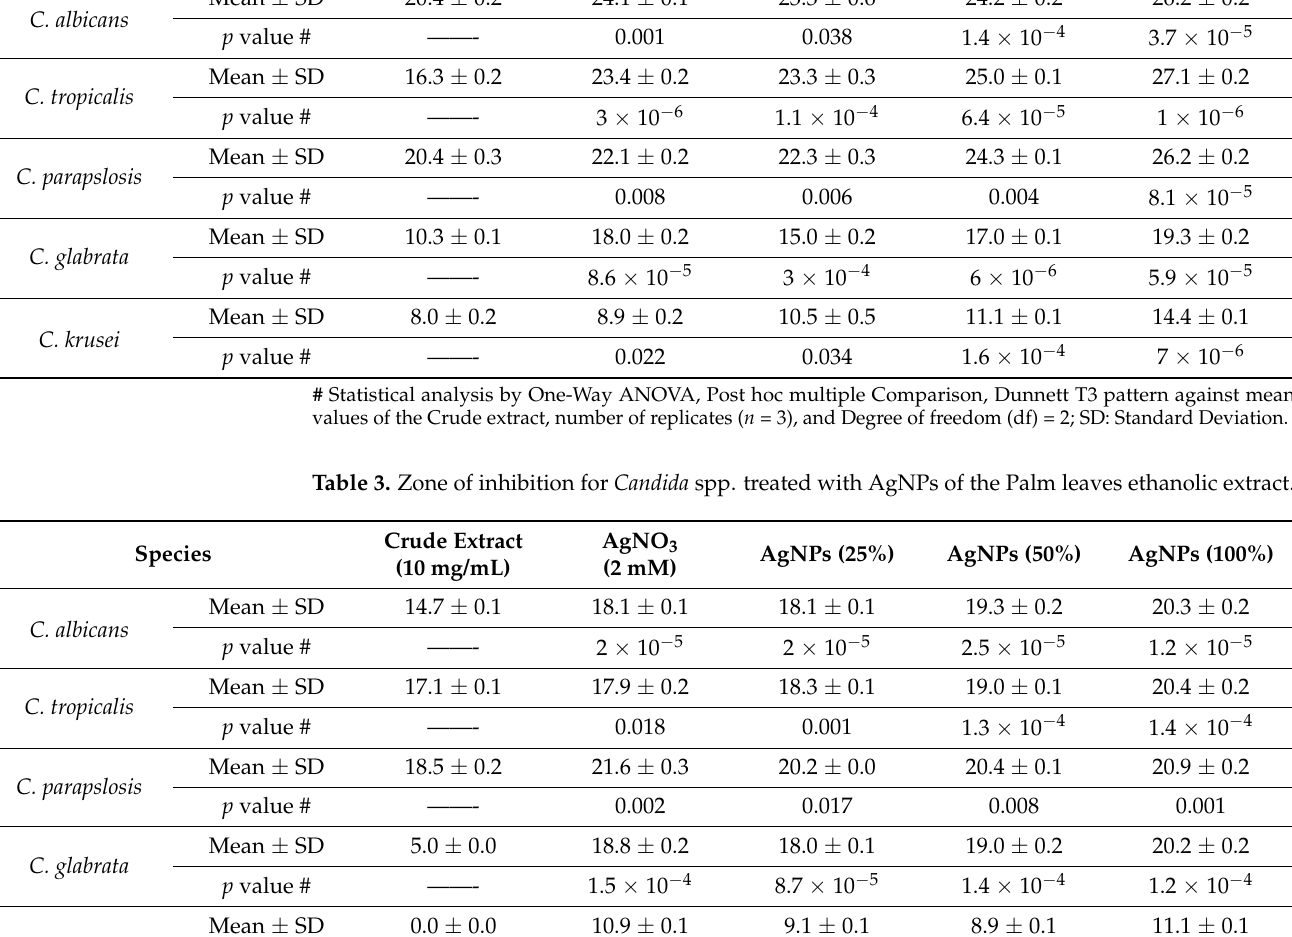
Table 2. Zone of inhibition for Candida spp. treated with AgNPs of the Palm leaves aqueous extract. Species